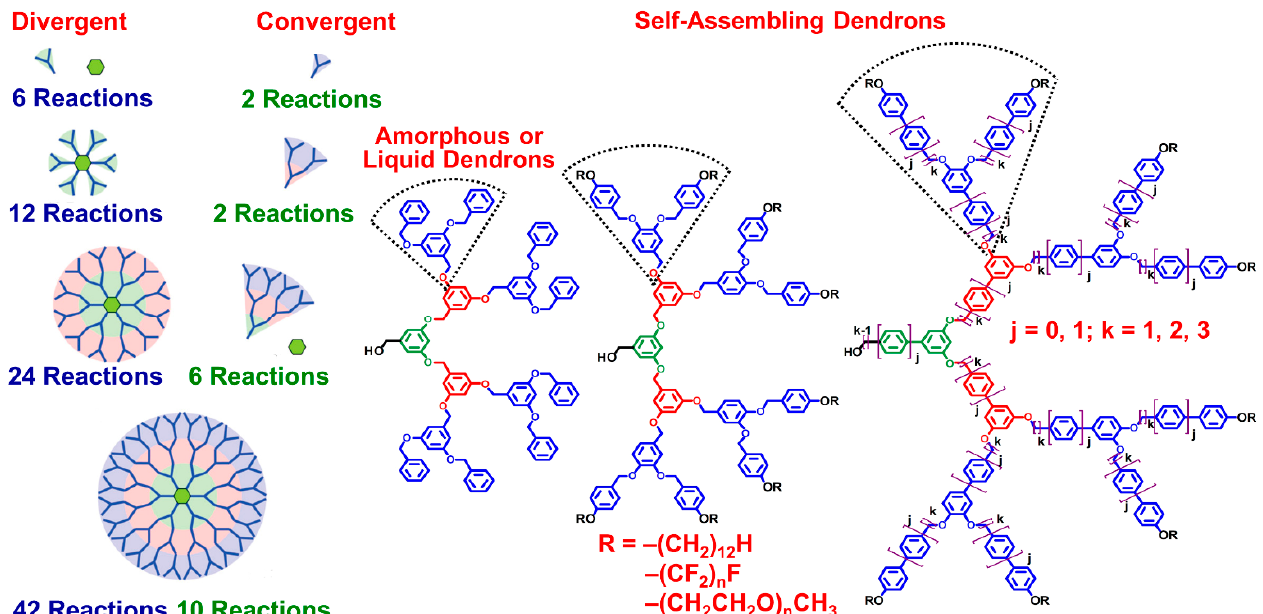
Figure 1. Divergent and convergent methodologies for the synthesis of dendrimers and dendrons displaying the number of reactions (left side); Examples of amorphous or liquid dendrons and self-assembling dendrons (right side) [60]. The parts of the Figure were adapted from [111] combined and modified. Copyright © 2009, American Chemical Society.